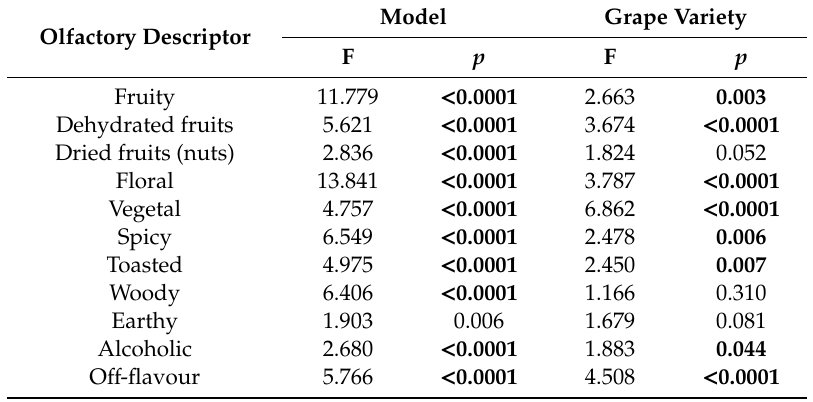
Table 3. Two-way ANOVA (judges as random factor and grape variety as fixed factor) computed to test the discrimination e ff ect of olfactory descriptors among the 74 red wines